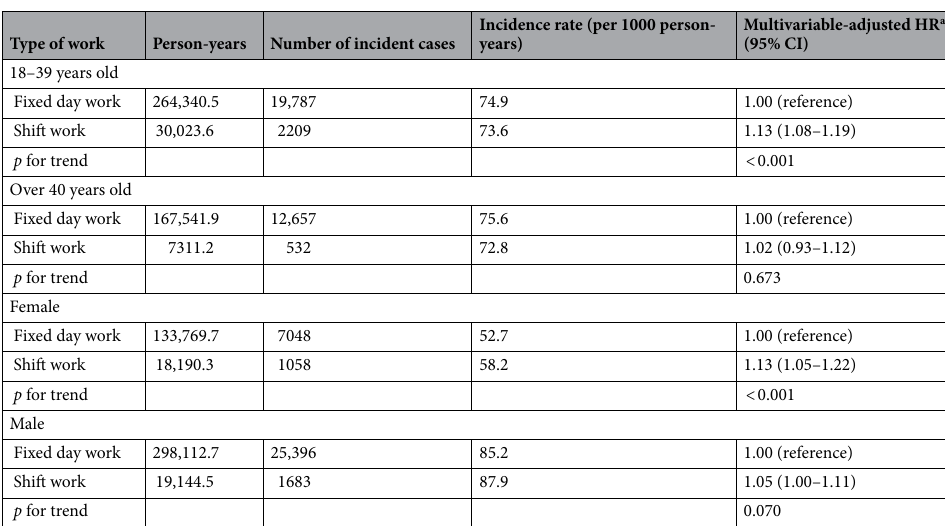
Table 3. Subgroup analysis of development of reflux esophagitis (RE) by type of work according to sex and age. CI confidence interval, HR hazard ratio. a Adjusted for sex, age, smoking status, alcohol intake, regular exercise, education level, BMI, Diabetes, dyslipidemia and working